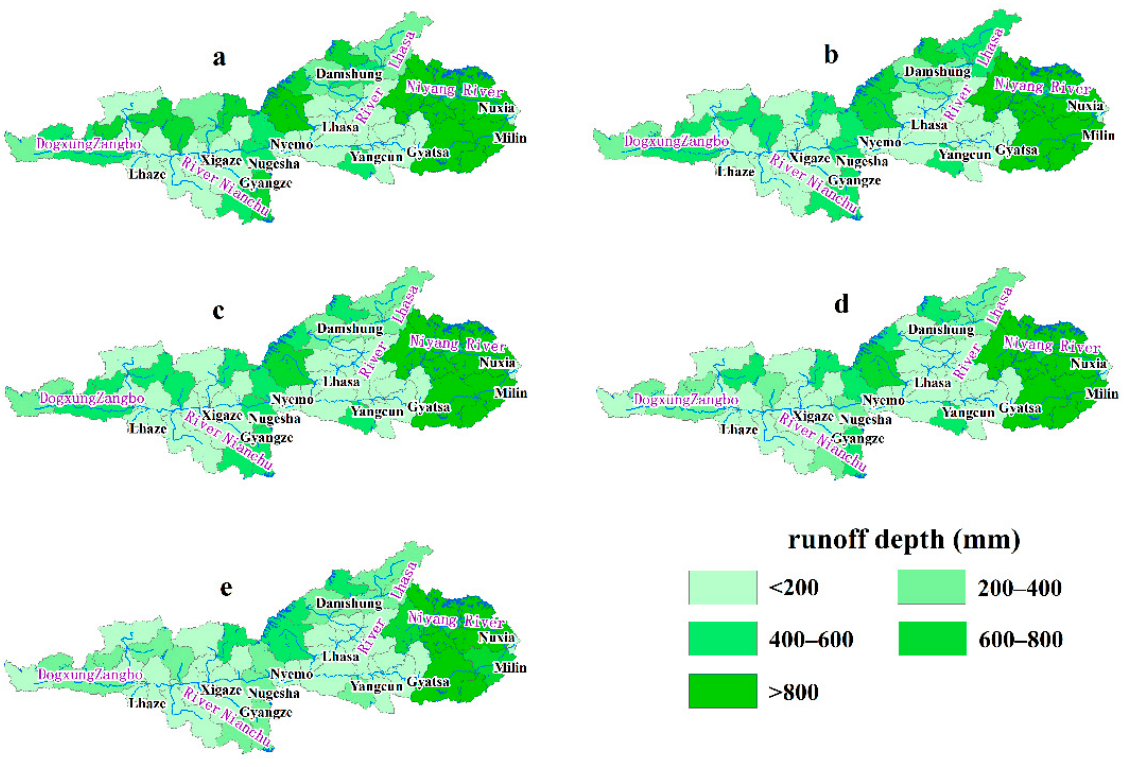
Figure 6. Spatial variation in total runoff depth in ( a ) especially high flow years; ( b ) high flow years; ( c ) normal flow years; ( d ) low flow years; and ( e ) especially high flow years.